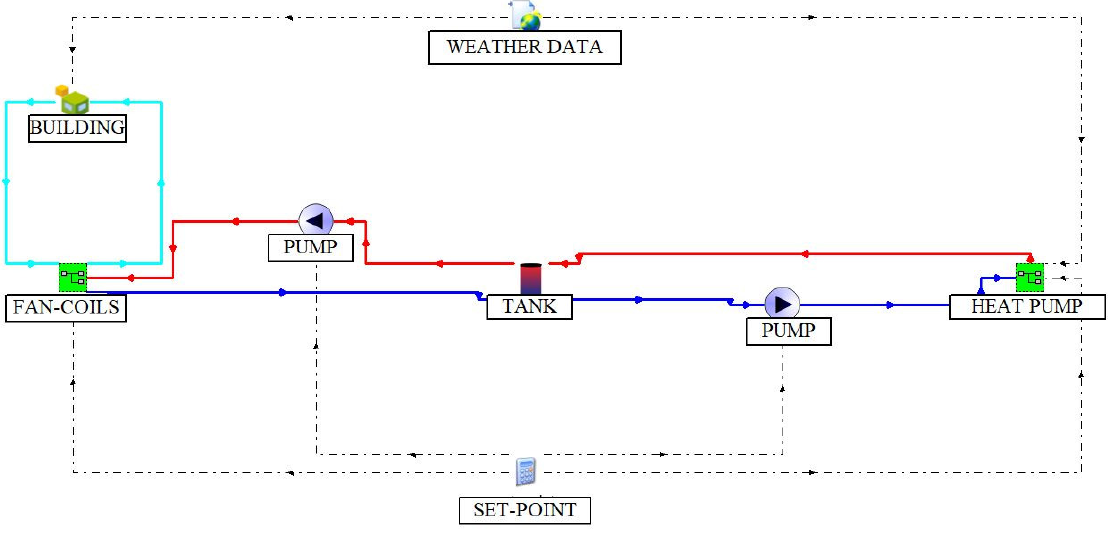
Figure 3. Layout of the heating system.